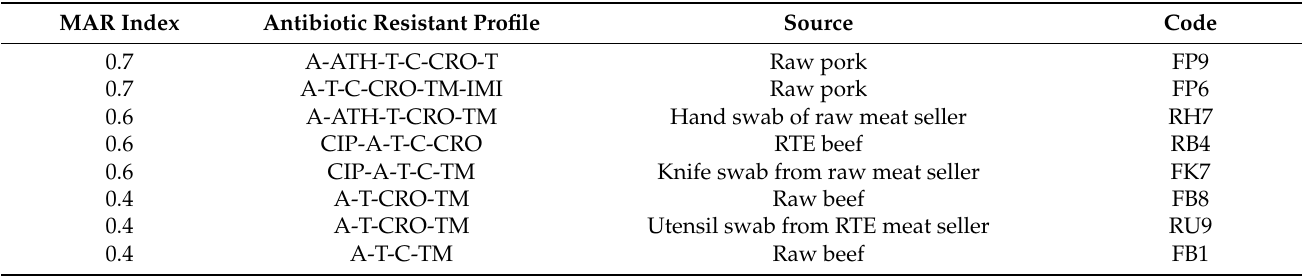
Table 3. Multiple antibiotic resistance index and antimicrobial resistance profile of individual E. coli species of raw meats, ready-to-eat (RTE) meats, and their related